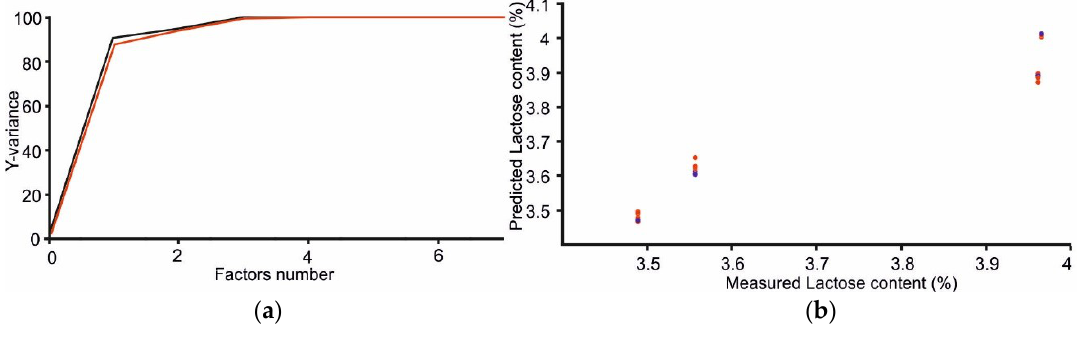
Figure 9. ( a ) Explained variance of lactose content in function of the number of latent variables; ( b ) linear correlation between lactose measured and lactose predicted. Table 3. Results of the PLS-1 analysis.